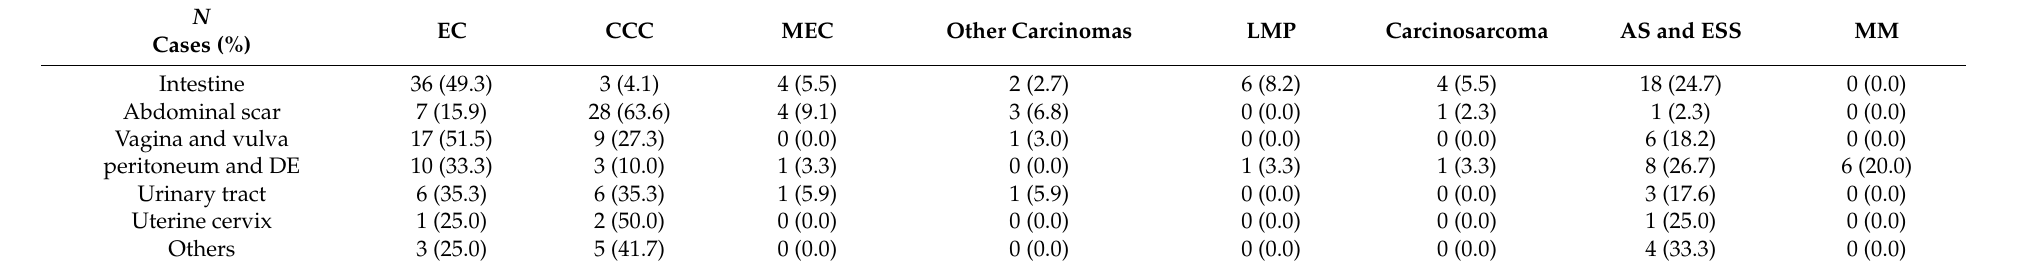
Table 3. Histological classification in each extraovarian